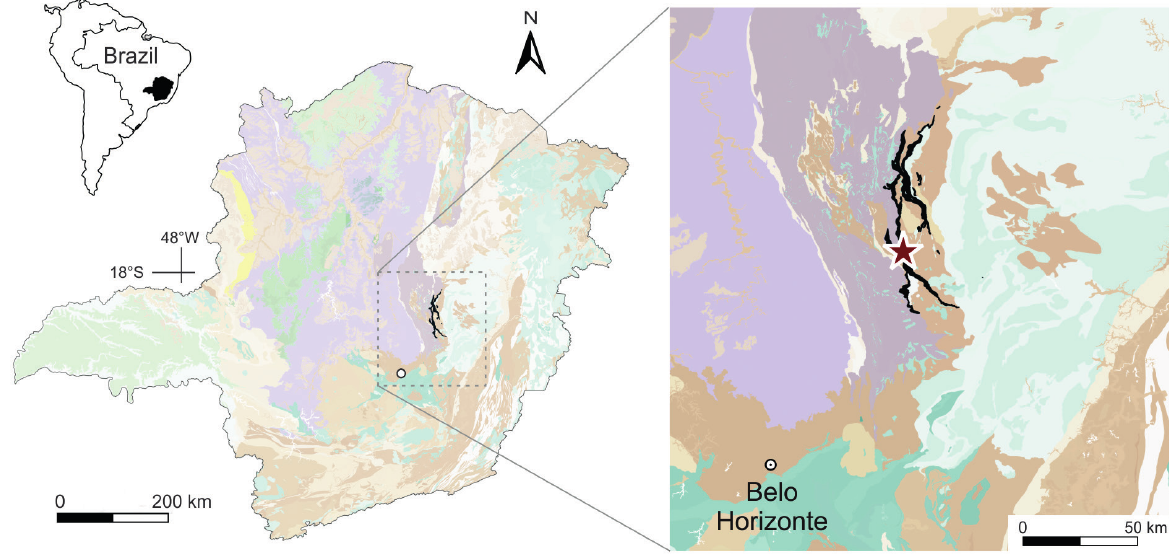
Figure 1 - Geological map of Minas Gerais showing the location of CMN-0022 cave (star). the Serra da Serpentina Group is highlighted in black. Modified from CPRM-CODEMIG (2014).